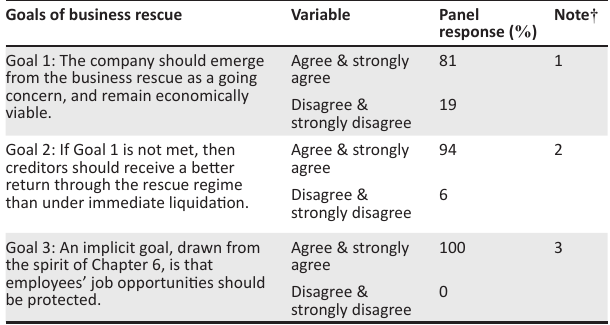
TABLE 3: The goals of business